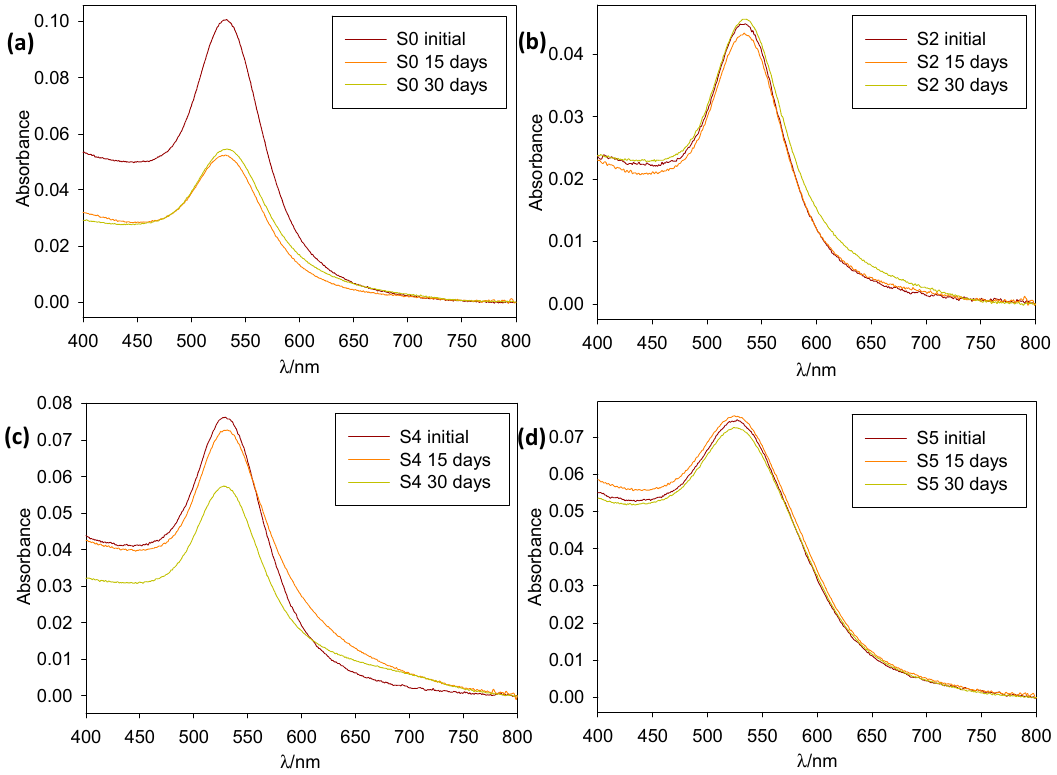
Figure 3. Normalized absorption spectra over time of 1:10 dilutions of samples ( a ) S0, ( b ) S2, ( c ) S4, and ( d ) S5.